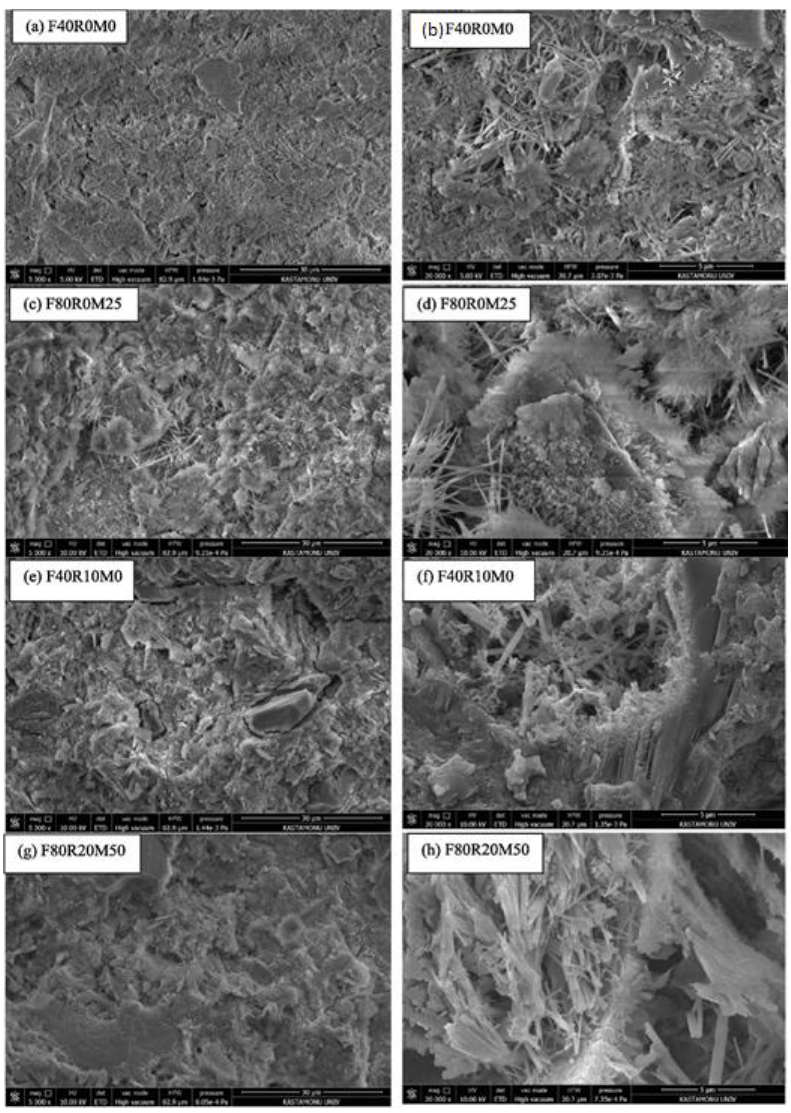
Figure 5 . SEM images of foam concrete samples (F: foam content, R: rice husk ash, M: waste marble powder). Reprinted/adapted with permission from Ref. [18]. 2021, Elsevier Science &Technology Journals.